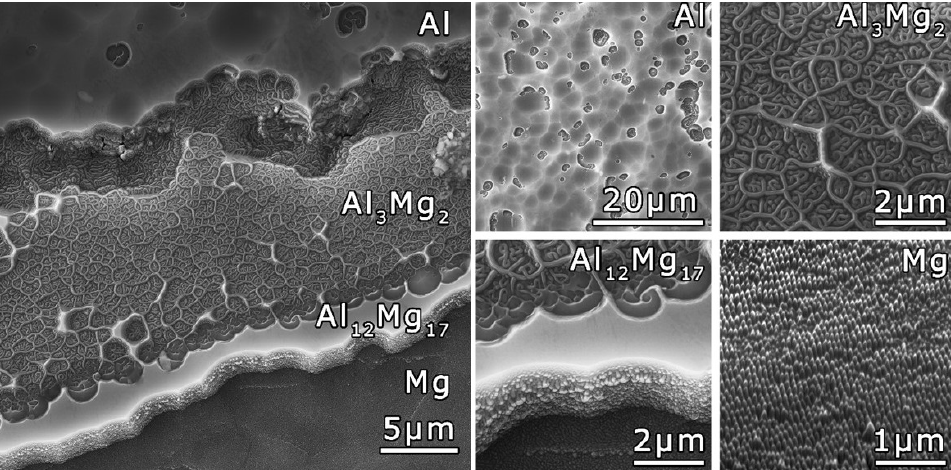
Figure 4. SEM images (SE mode) of the Al-Mg nanostructured composite surface after ion irradia- tion. Tilt angle is 45°. Tilt angle is 45 ◦